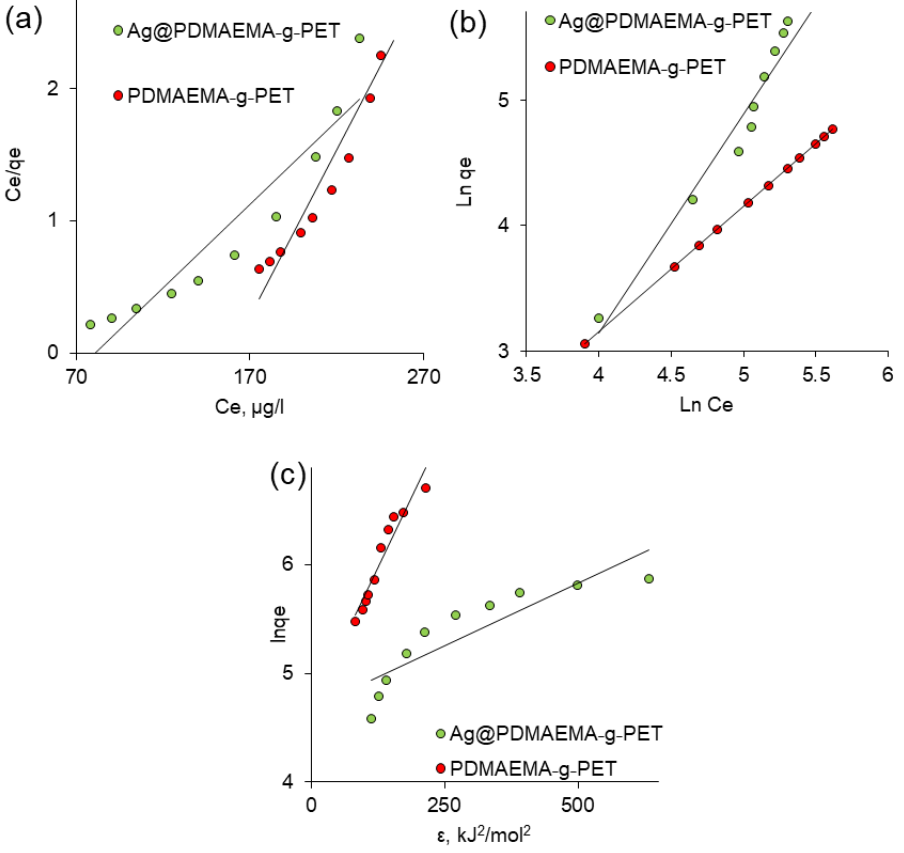
Figure 10. Fitted Langmuir ( a ), Freundlich ( b ), and DR ( c ) adsorption isotherms for the adsorption of As(III). Table 2. Parameters calculated from various isotherm models (initial As(III) concentration: 50 ppm, pH: 4.0).